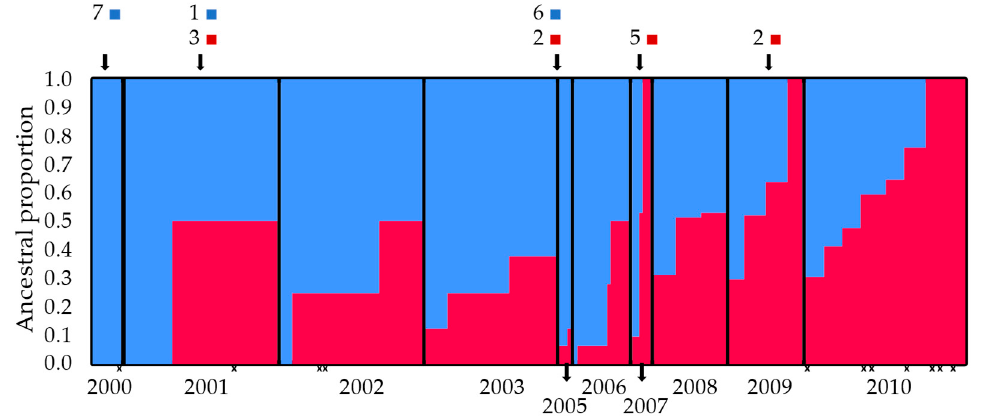
Figure 5. Ancestral proportion (blue: western subpopulation and red: eastern subpopulation) of captive-born Parantechinus apicalis calculated from the pedigree. Each bar represents one individual and black bars separate birth years. X marks individuals who died in captivity or were kept for next breeding season. Top inset indicates numbers of founders from different sources that contributed to the gene pool of the captive population at different time points. Note that the numbers do not match Table 1 because some founders did not contribute to the gene pool.